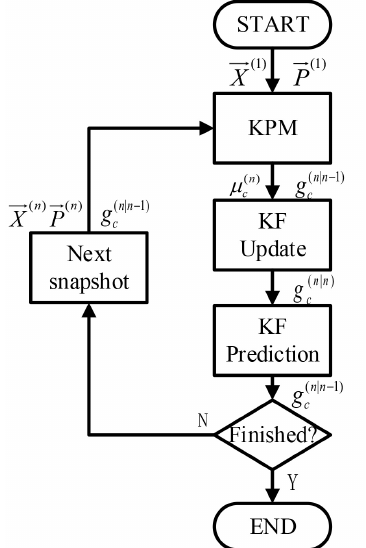
Figure 4. Flowchart of the K-power means-Kalman filter (KPMKF)